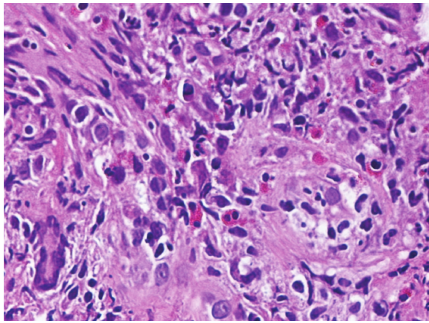
Figure 3: Histology revealed the presence of granulomatous inflam- mation with scattered giant cells and